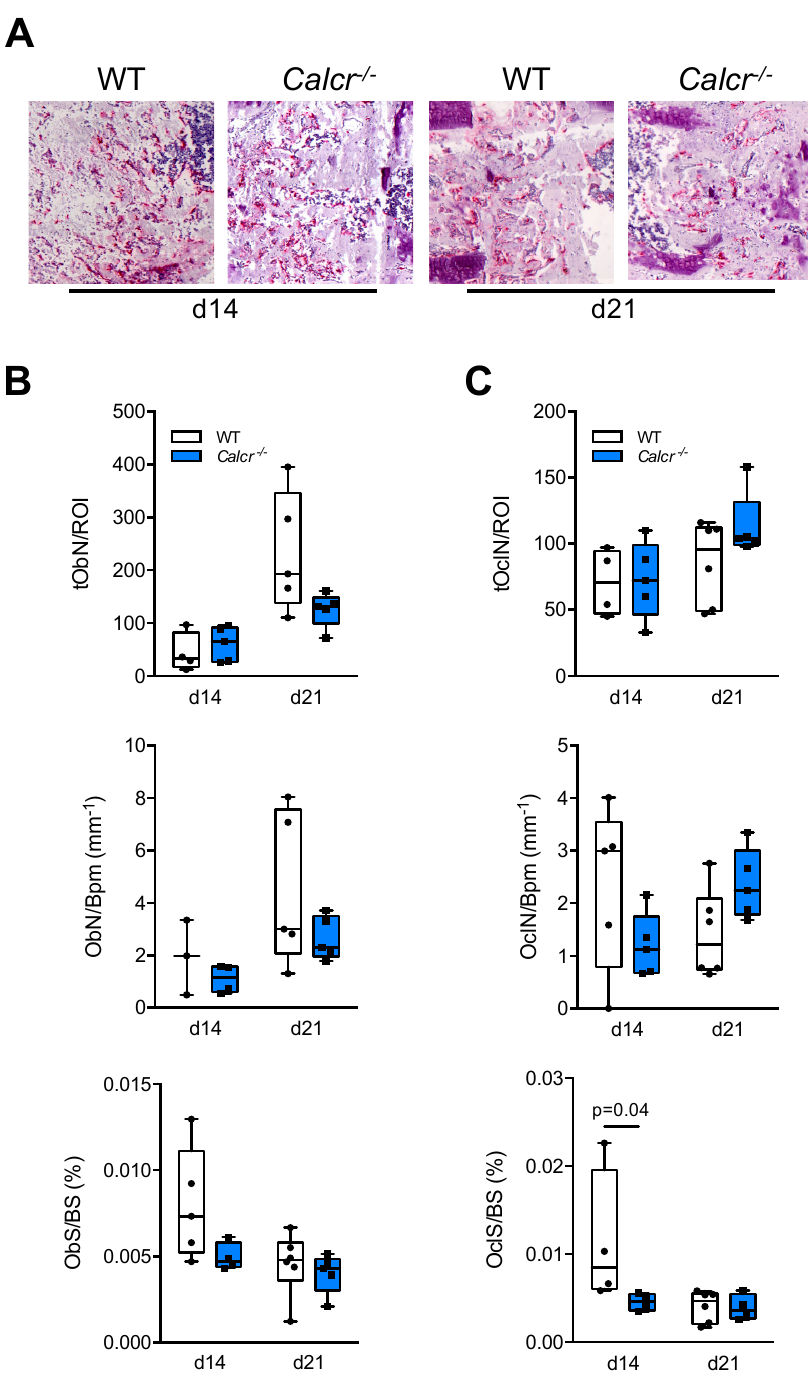
Figure 6. No major alteration in bone cell distribution in the callus of CTR-deficient mice ( A ) Representative TRAP-stained callus sections at day 14 and 21 in WT and CTR-deficient mice. ( B ) Histomorphometric quantification of osteoblast parameters in the callus of WT and CTR-deficient mice at the indicated time points. tObN/ROI = osteoblast numbers in the callus area, ObN/Bpm = osteoblast numbers per bone perimeter, ObS/BS = osteoblast surface per bone surface. ( C ) Histomorphometric quantification of osteoclast parameters in the callus of the same mice. tOcN/ROI = total osteoclast numbers in the callus area, OcN/Bpm = osteoclast numbers per bone perimeter, OcS/BS = osteoclast surface per bone surface. n = 3–6 mice per group and time point as indicated.